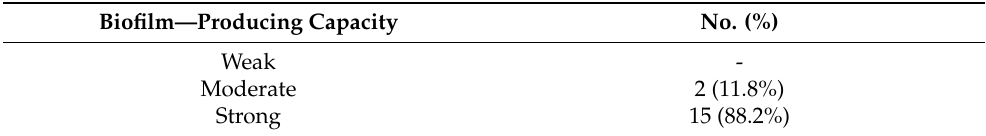
Table 4. Biofilm formation of Staphylococcus aureus isolates.